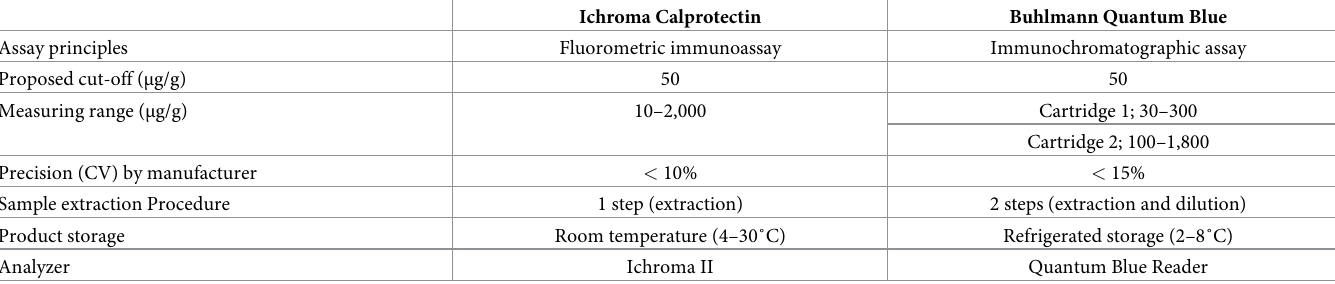
Table 1. Characteristics of two quantitative rapid assays for fecal calprotectin measurements.